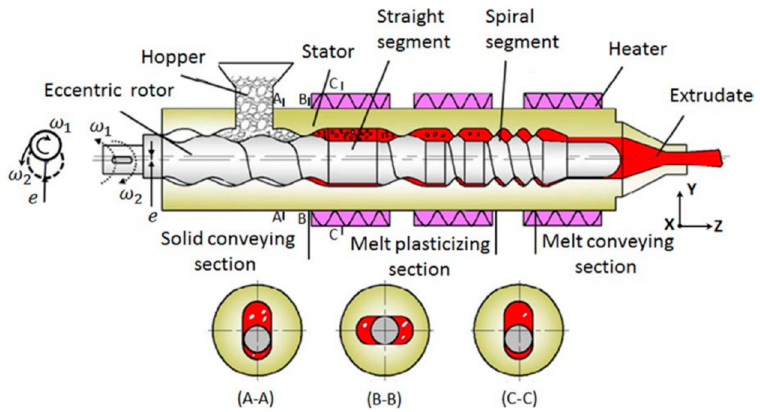
Figure 4. Structure of the eccentric rotor extruder (ERE) with different rotating states. Reproduced with permission from [25]. Copyright 2018, John Wiley and Sons.